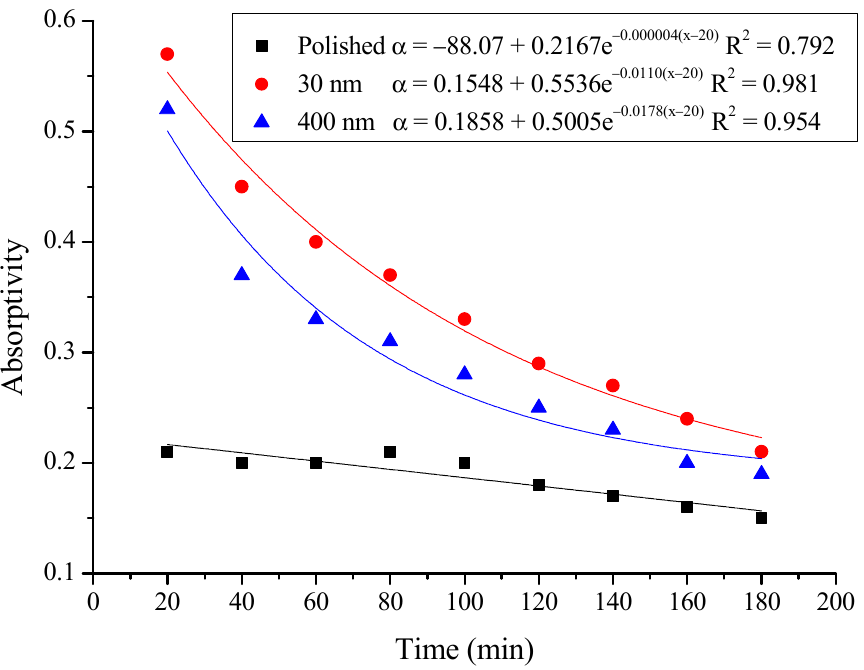
Figure 15. Variation of the average absorptivity for the testing rigs operated under the simulated radiation of 200 W / m 2 .